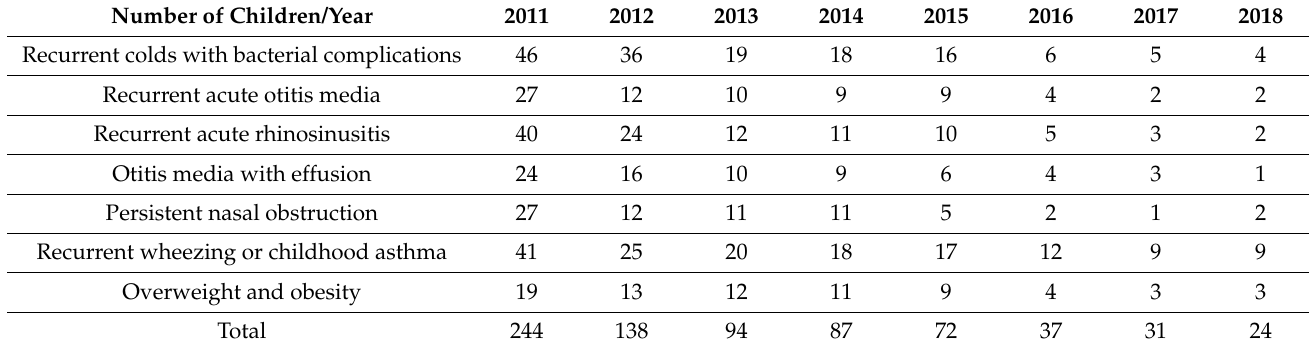
Table 2. The evolution of the number of patients diagnosed with IRD each year after progressive introduction of the